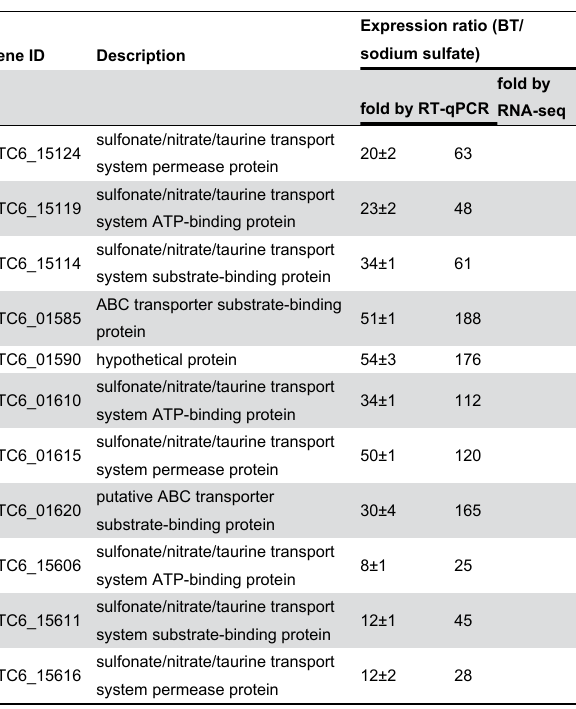
Table 1. Significantly up-regulated genes of strain C-6 cultured with different sulfur